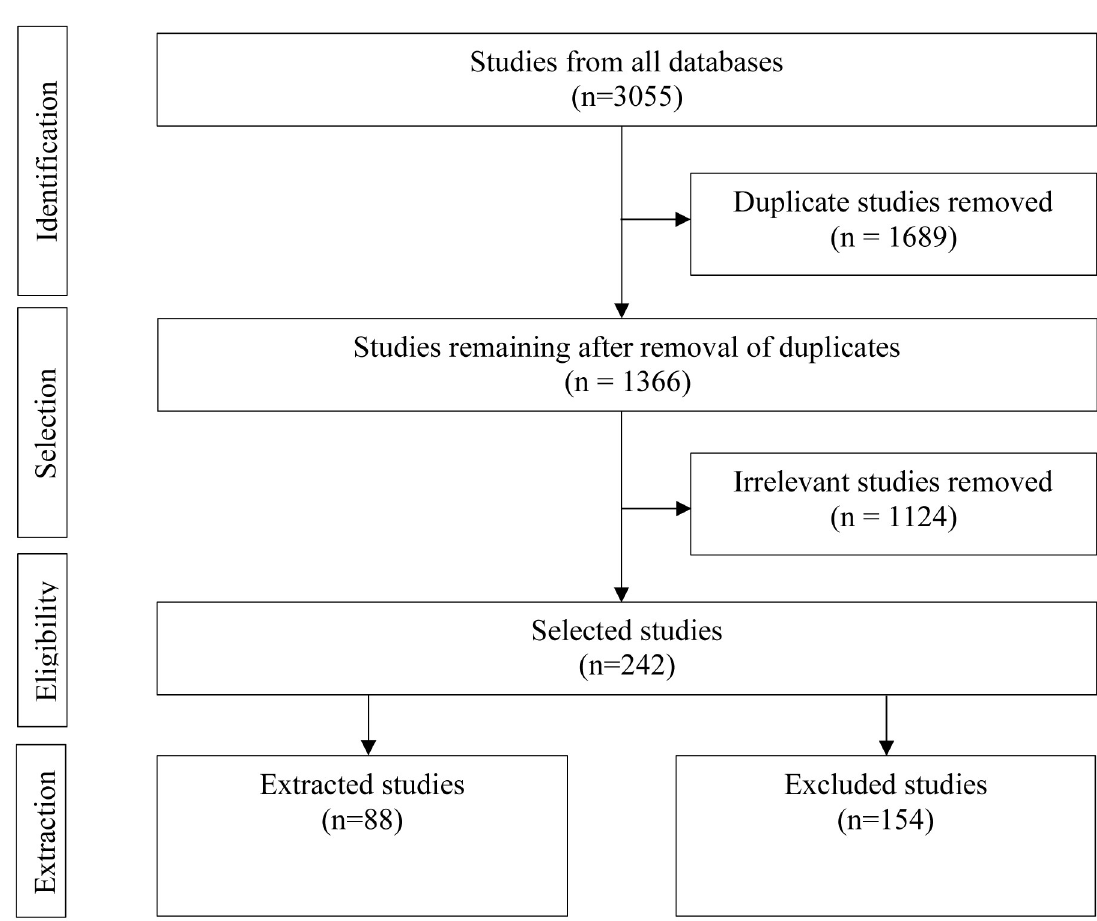
Fig 1. Flowchart using the Preferred Reporting Items for Systematic Reviews and Meta-Analyses extension for Scoping Reviews (PRSMA-ScR) for study selection.